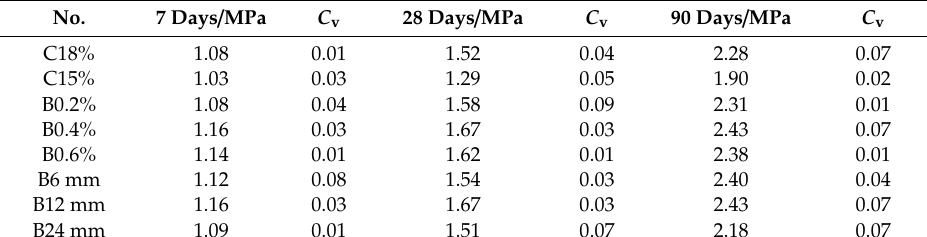
Table 7. Unconfined compressive strength.